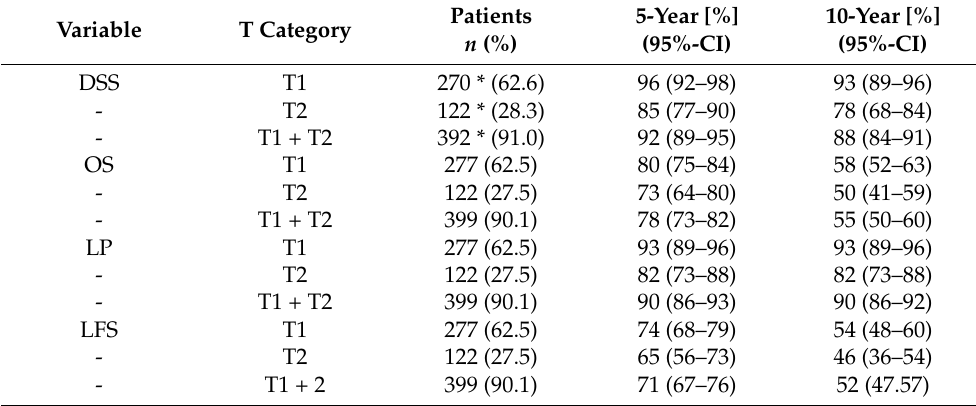
Table 4. Survival and larynx preservation after TLM in T1, T2 and T1 + T2 laryngeal cancer patients of all primary tumor